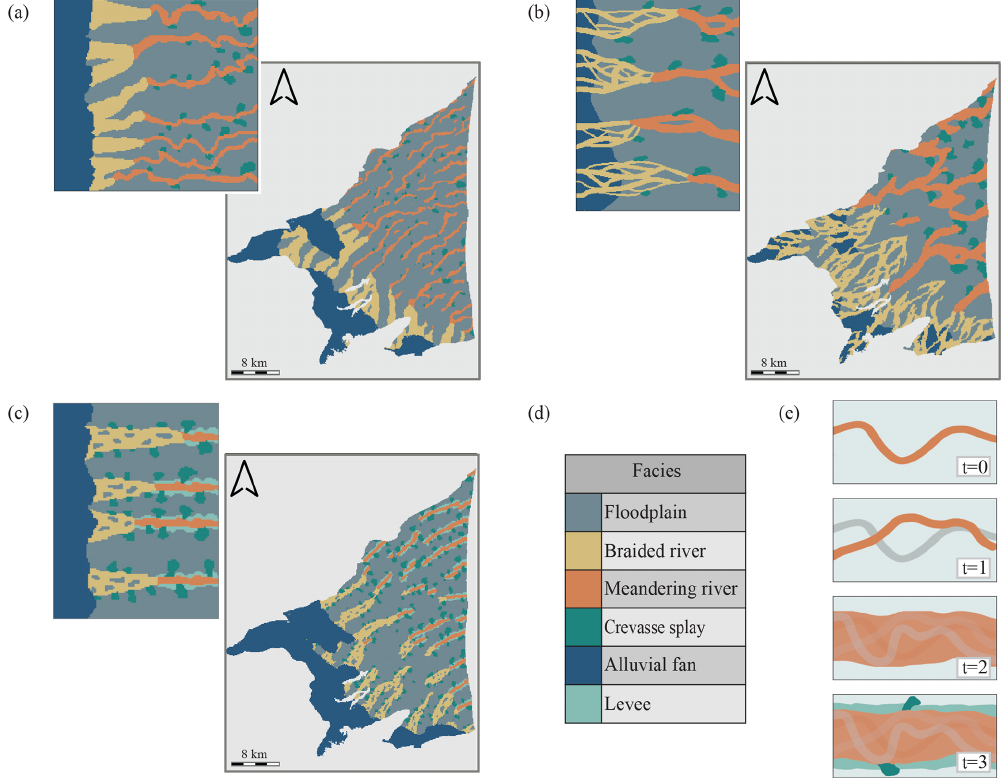
Figure 2. Horizontal training images (TIs) associated with their corresponding 2D MPS simulations. (a) Analog TI derived from satellite images of the Tagliamento River, (b) a conceptual analog TI, and (c) a TI created based on outcrop descriptions and general knowledge of the Roussillon plain. (d) The six sedimentary facies of the final TI. (e) Illustration of the sedimentological concept for the creation of the final TI: the aim is to simulate the area of high river bed occurrences (channel belt) rather than individual river